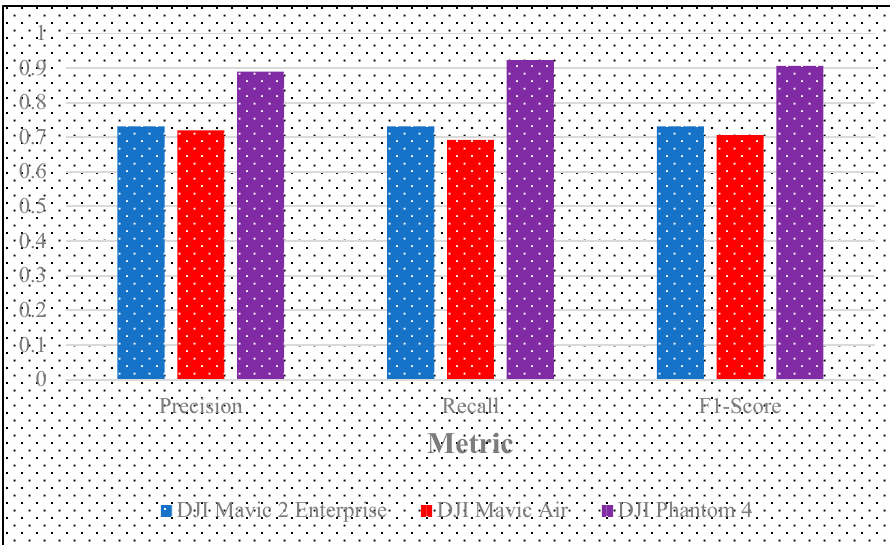
Figure 7. Per Class Metrics for Prediction of Test Images Using Trained MobileNet v2 Model.